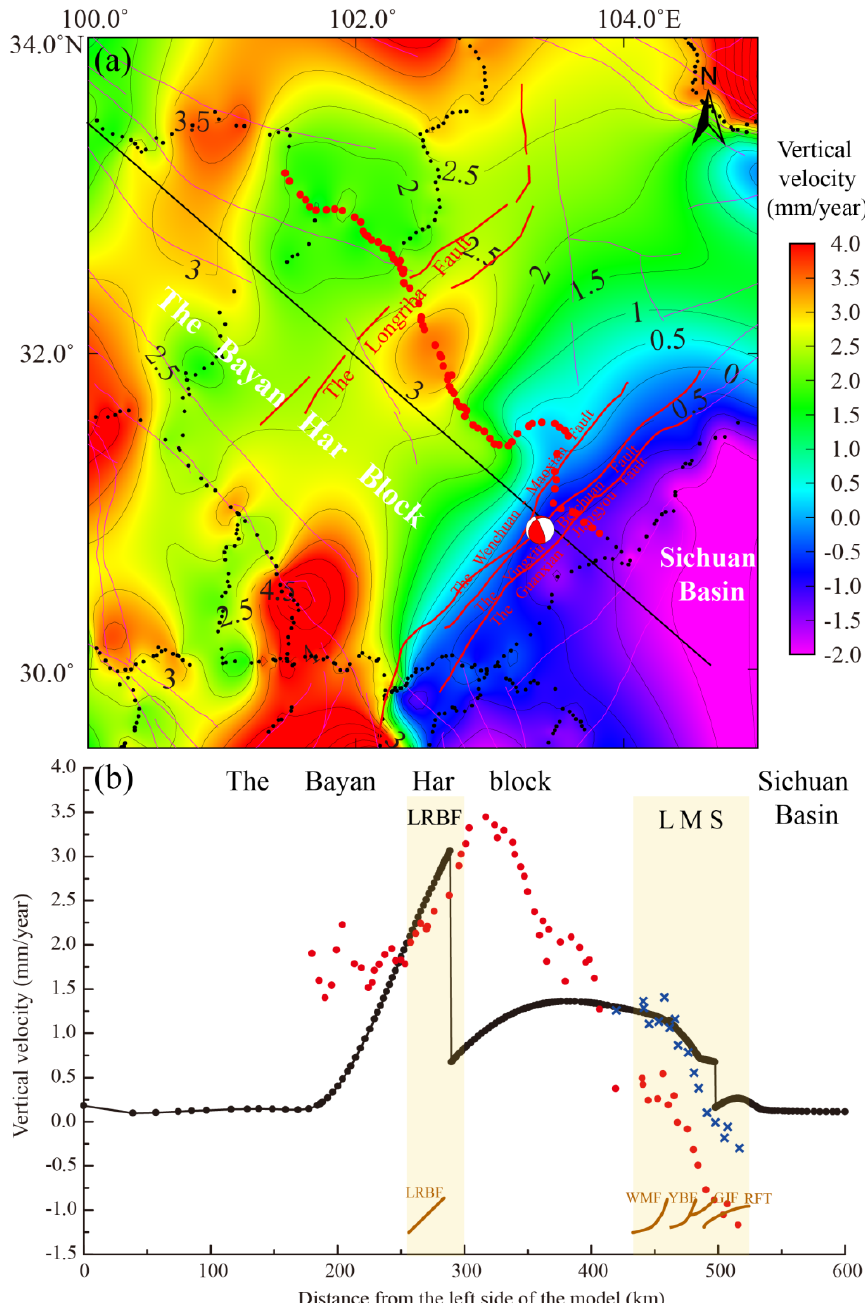
Figure 4. Comparison of observed and simulated vertical velocity. ( a ) vertical velocity field obtained by interpolation of precise leveling data in the study area; Black dots: Observation stations of precise leveling; Red dots: The observation stations used in Figure 4b; Beach ball: Wenchuan mainshock; Grey line: Isoclines with interval of 0.5 mm/yr.; Black line: The location of two - dimension model used in this study; Red lines: Faults simulated in the Model 4; Magenta line: Active faults in the study area; Black dotted Line: the starting and ending points of precise leveling station used in Figure 4b. ( b ) comparison of observed and simulated vertical velocity results; Black line with dots: Simulated results in Model 4; Red dots: Observed results of precise leveling projected to the profile of Model 4; Blue cross point: Revised precise leveling data; Yellow areas: The Longriba fault and the Longmen Shan thrust belt; Grey lines: Faults in the models.